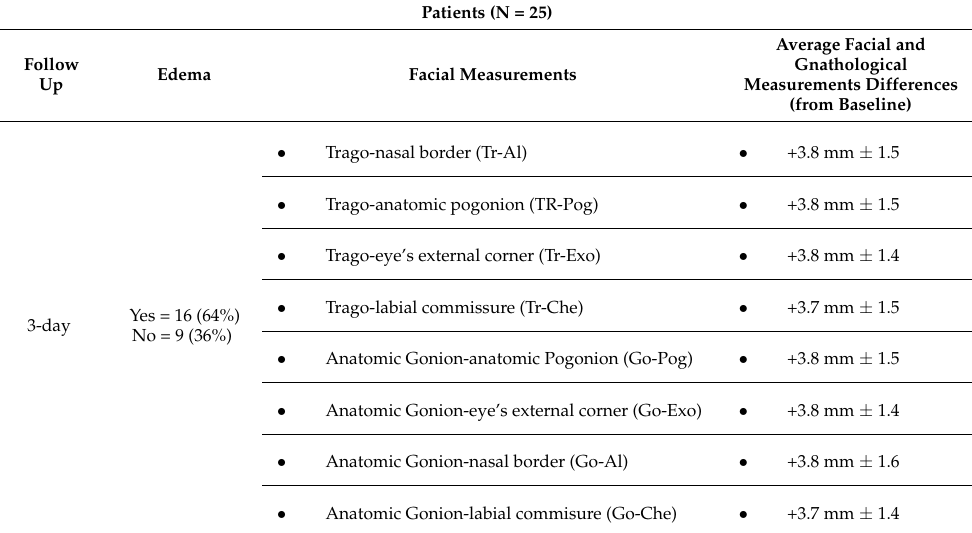
Table 6. Average facial and gnathological measurements differences from